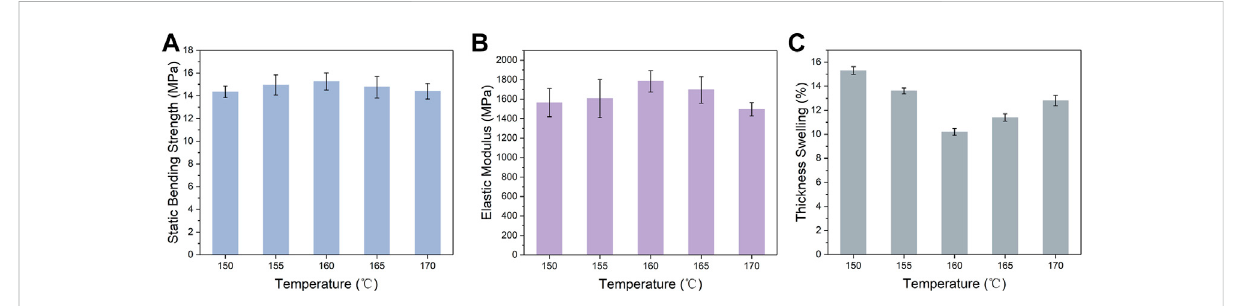
FIGURE 1 (A) Static bending strength of PF/SF. (B) Corresponding elastic modulus of PF/SF. (C) The thickness swelling of PF/SF. The fi ber content is 50% and the hot-pressure time is 9 min.